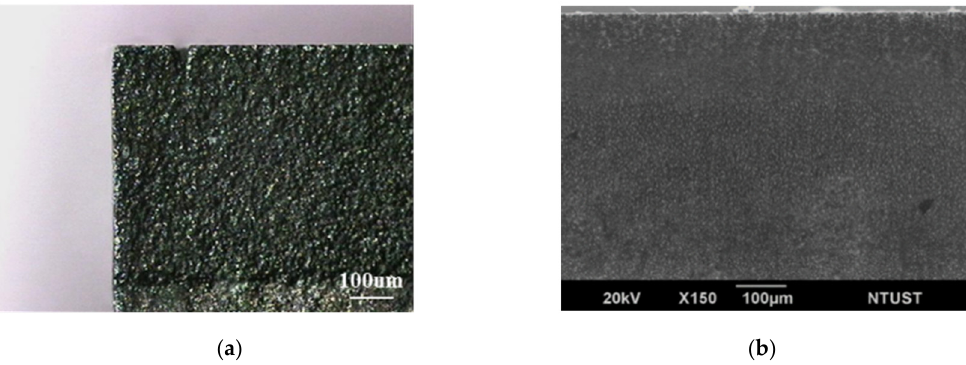
Figure 18. Optical microscope image ( a ) and SEM morphology ( b ) of the PCD workpiece processed using Method 3 with the stage tilted by 5.2°.